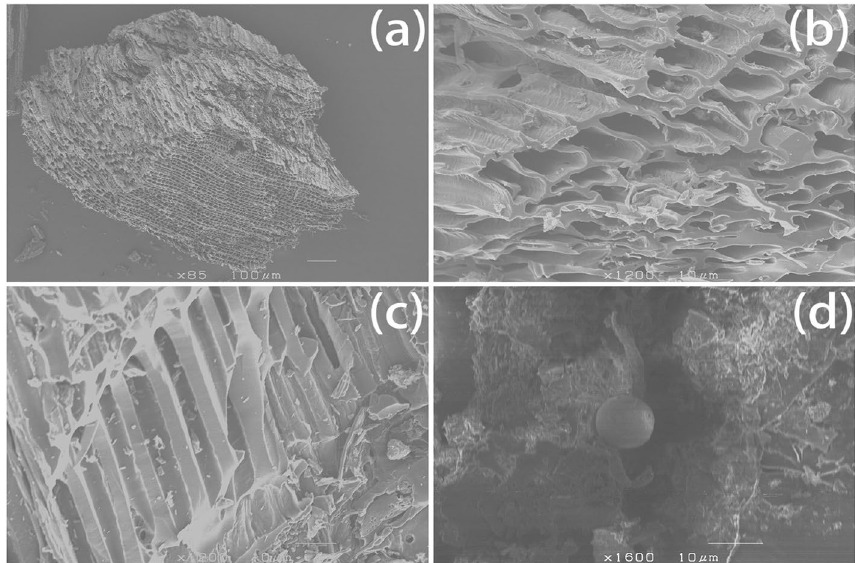
Fig. 6 Structure of biochar from wood chips of conifer. All photographs were taken by SEM: a Biochar granules (85 (350 ); c Fence-like structure inside (1200 ×